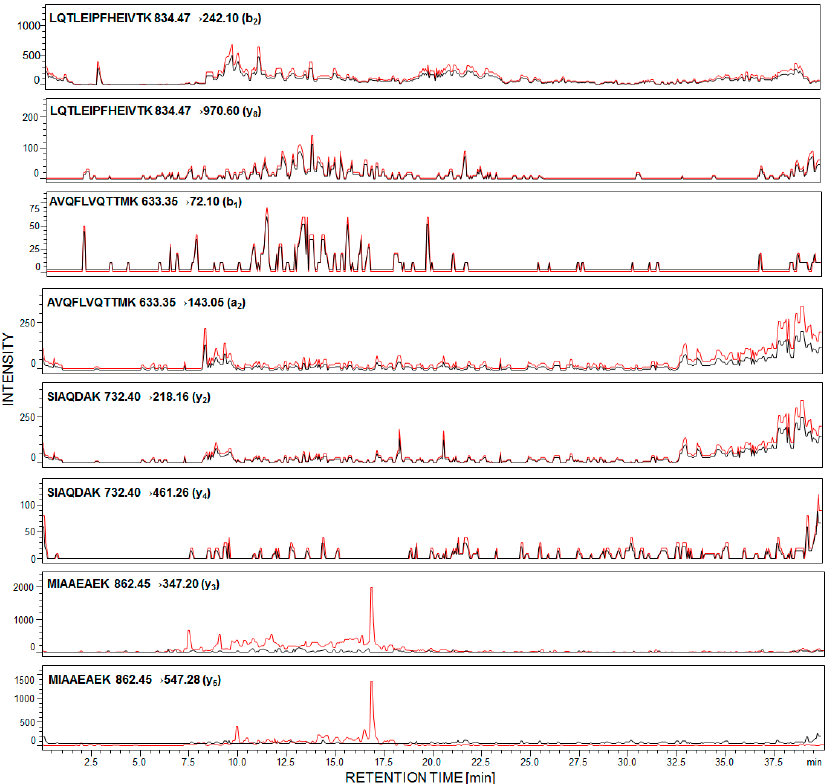
Figure 2. Multiple-reaction-monitoring (MRM) analysis of urine sediment tryptic digest from healthy subjects (black line) and pregnant women with diagnosed preeclampsia (red line).